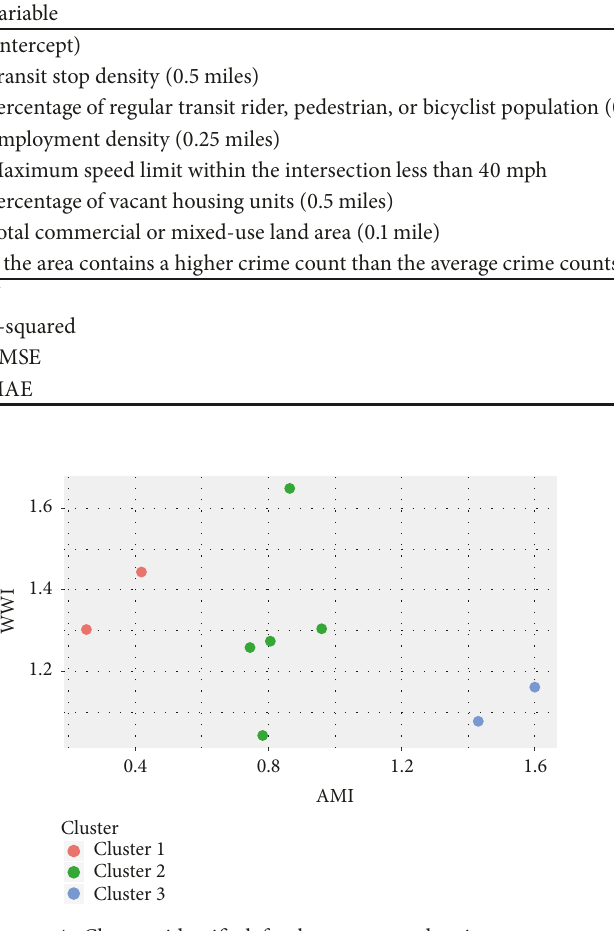
Figure 4: Clusters identified for long-term pedestrian counters (each circle in the plot represents a long-term pedestrian